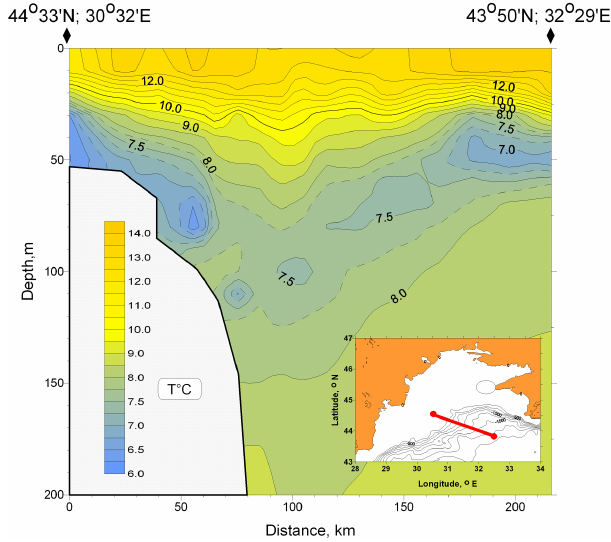
Fig. 1. Dense water cascade in the Black Sea, May 2004, (Shapiro,